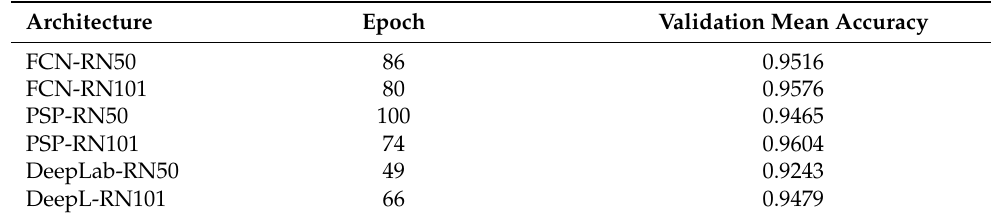
Table 1. Validation Accuracy of the Training